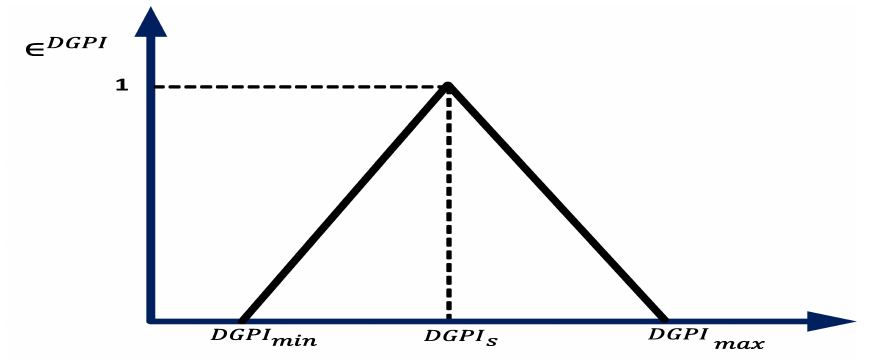
Figure 5. DG penetration.